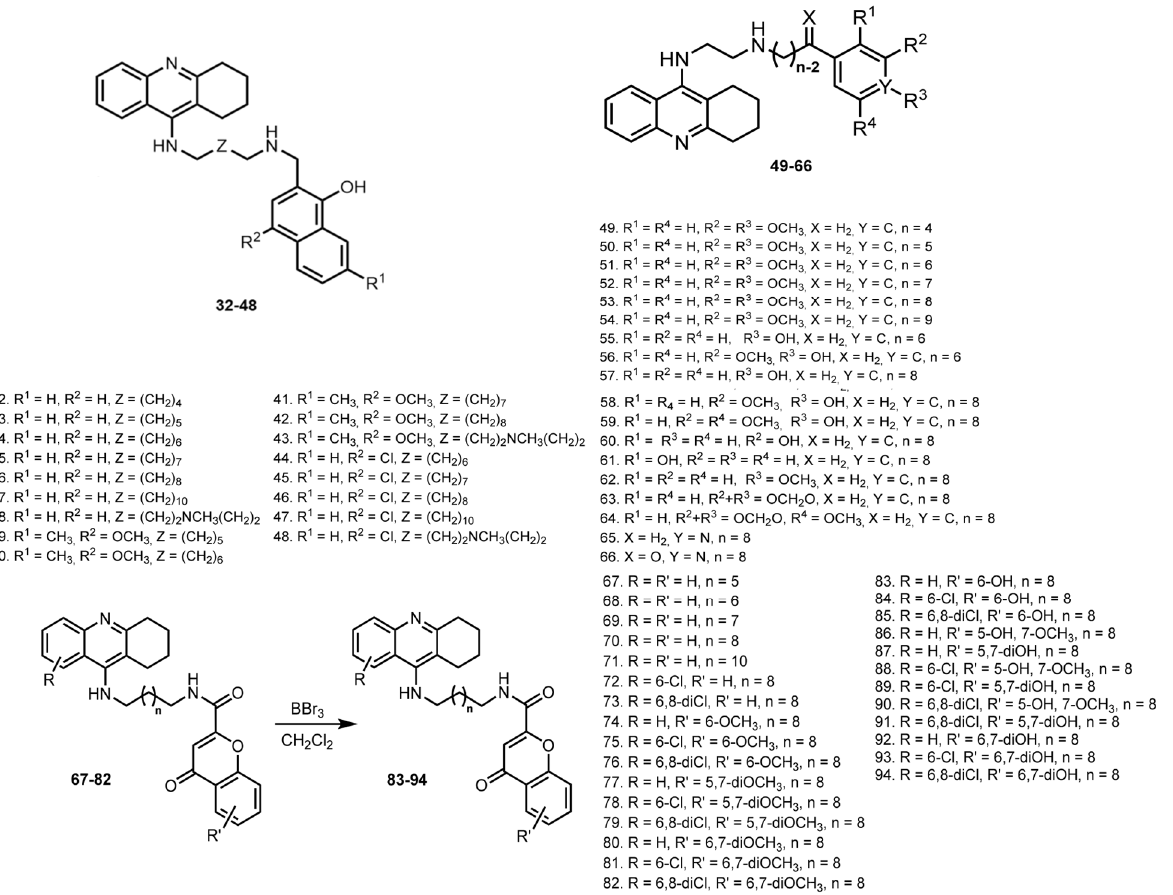
Figure 5. THA–hydroxyquinoline hybrids 32 – 48 [42], THA hybrids with benzene/pyridine moieties